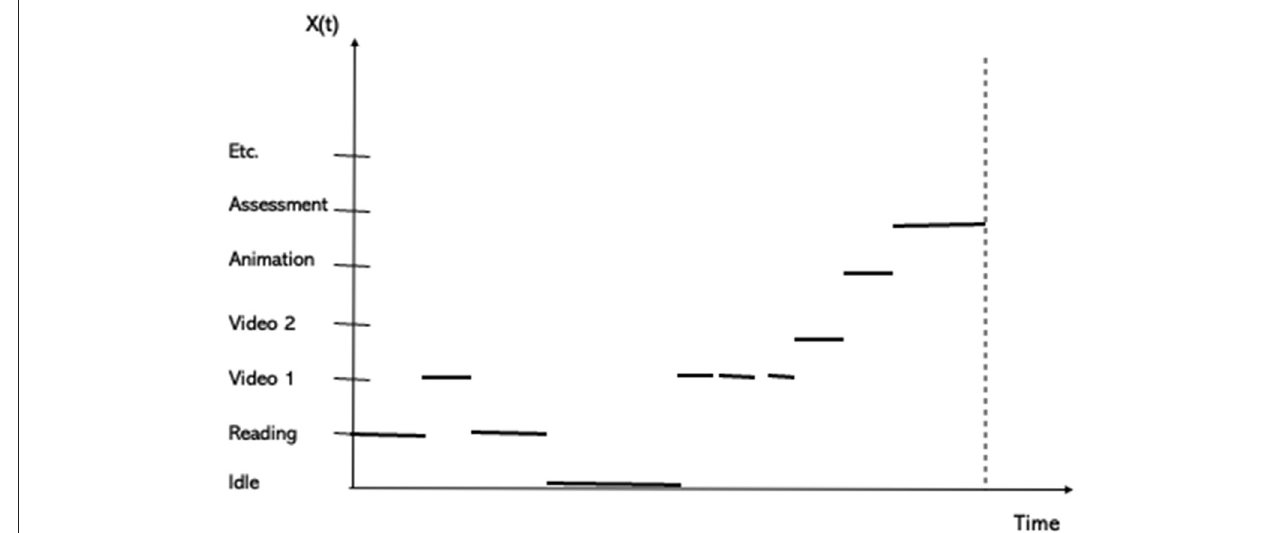
FIGURE 9 | An illustration of some of the activities of a learner during a learning session.